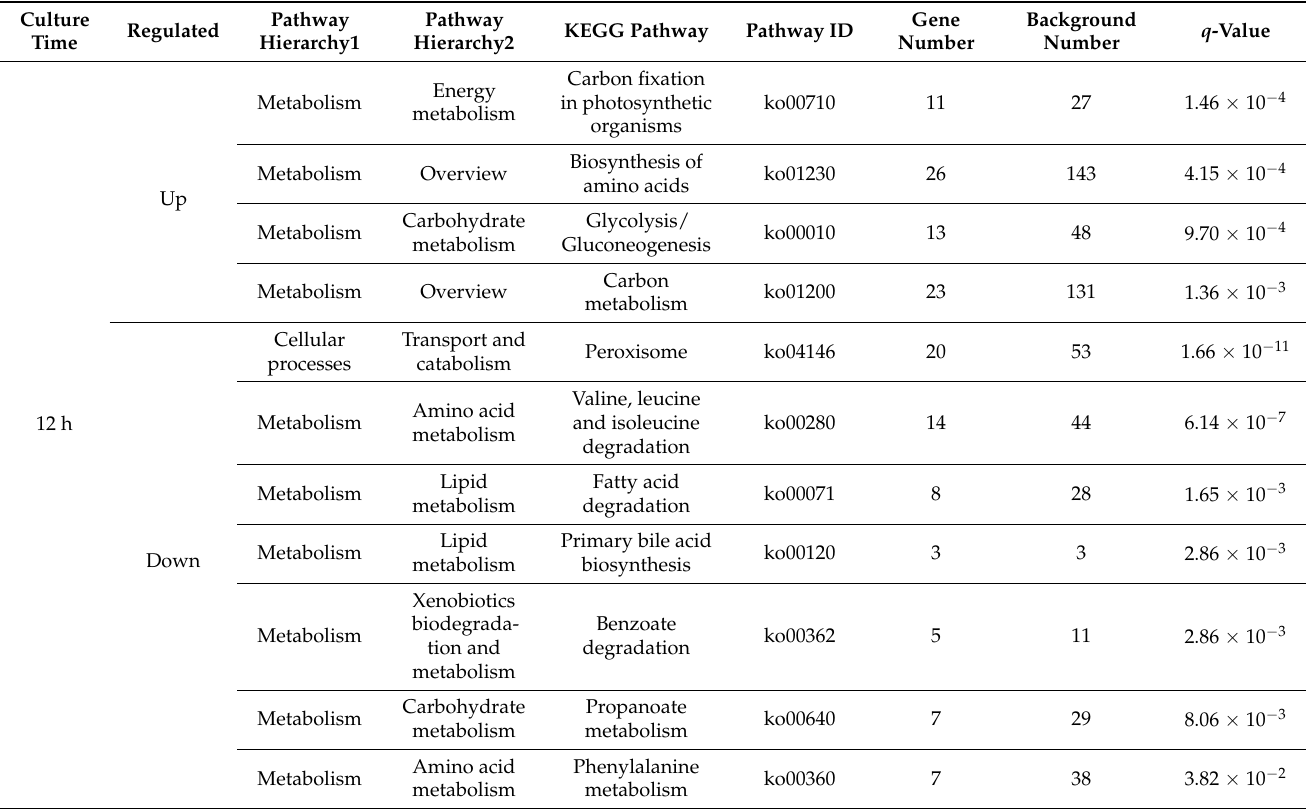
Table 2. Significantly enriched KEGG pathways ( q ≤ 0.05) of DEGs in T. harzianum T4 grown for 12, 24, 48 and 72 h in the presence of BCCW.